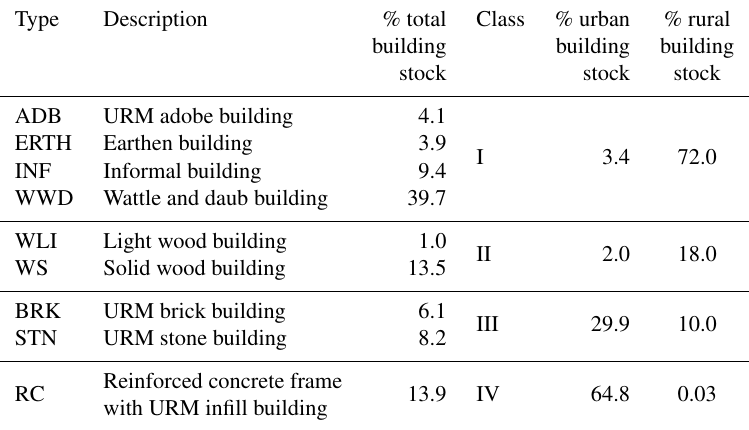
Table 9. Ethiopian building stock according to ImageCat